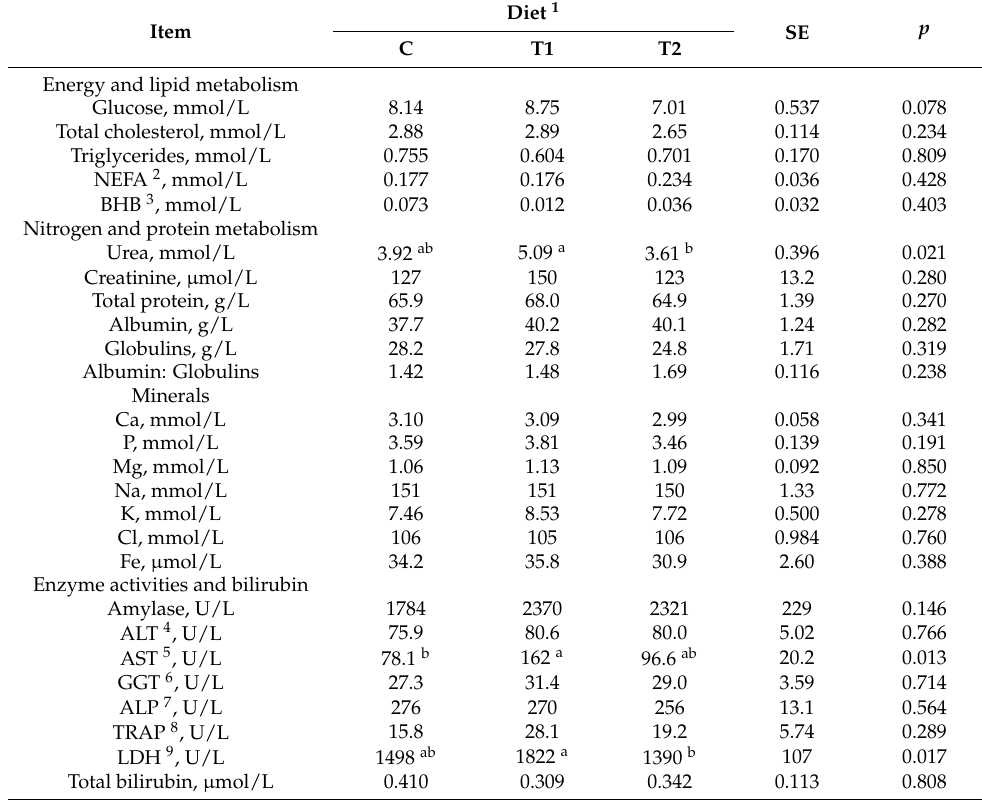
Table 3. Results from the analysis of variance of plasma metabolites and enzymatic activities in piglets at the end of the experimental